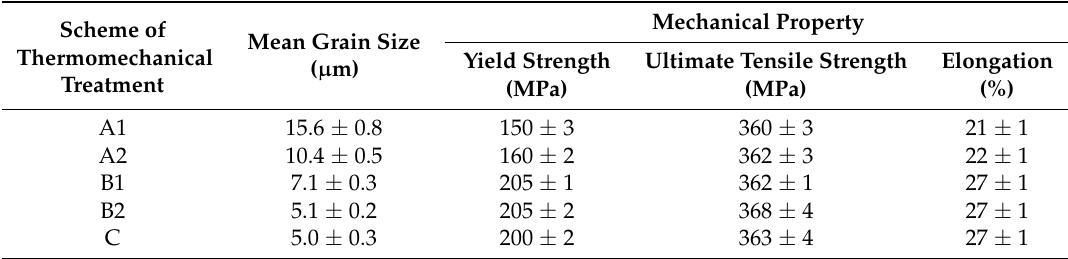
Table 4. Mechanical properties of sheets.